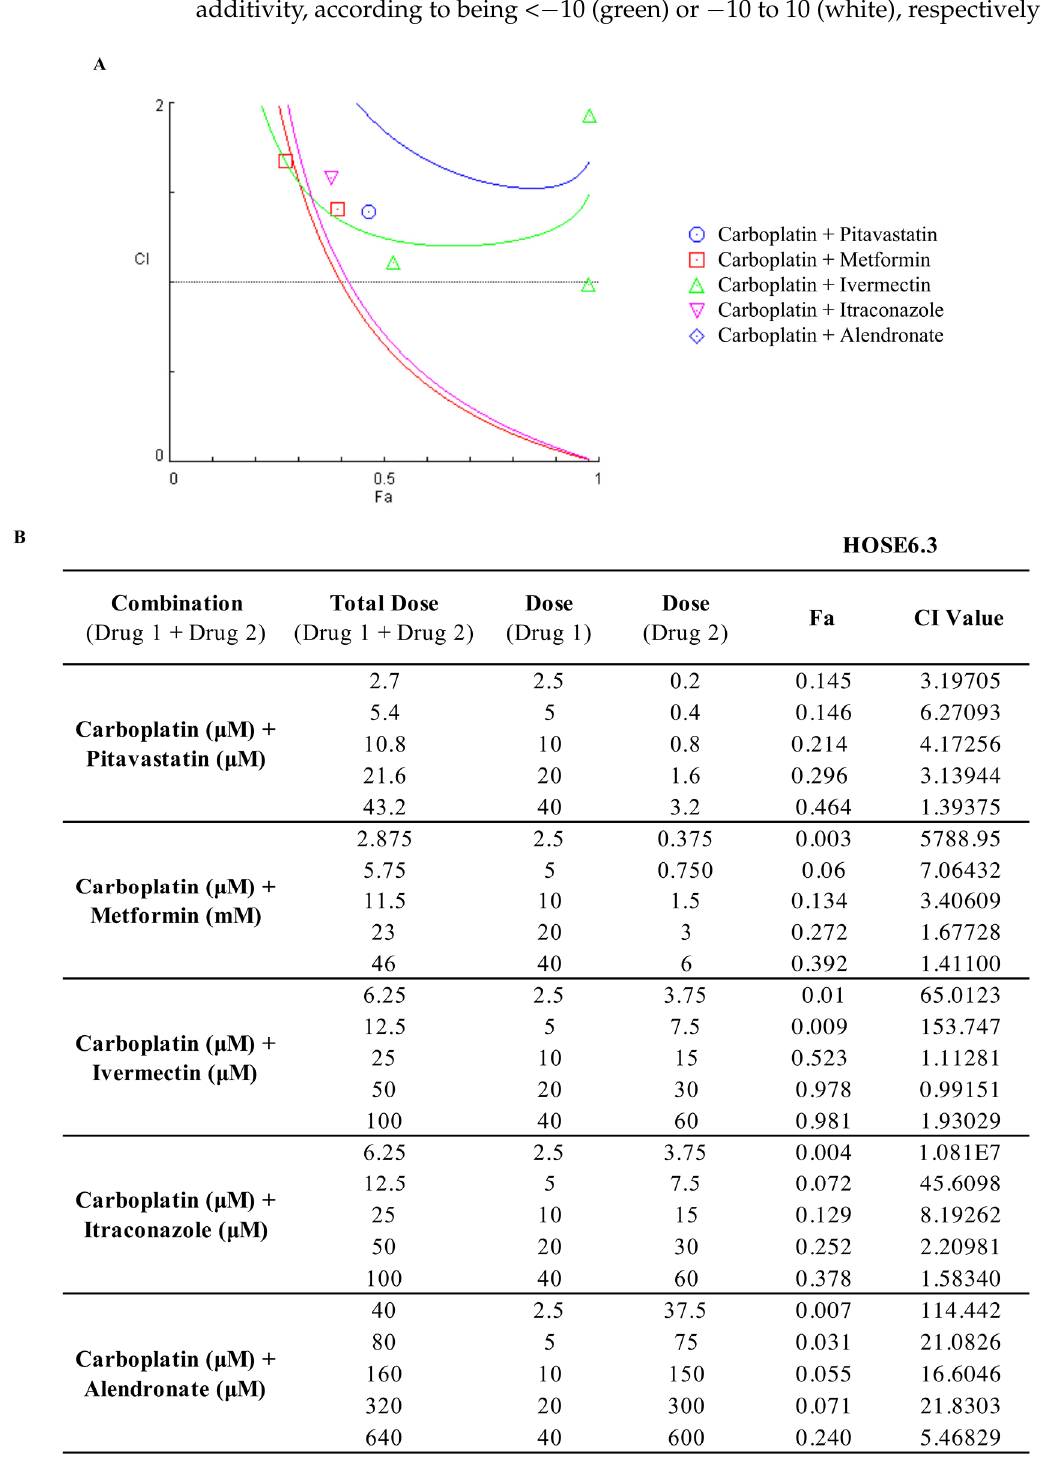
Figure 6. Combining Carboplatin with repurposed drugs has an antagonistic effect on HOSE6.3 cells. ( A ) Chou–Talalay method effect level (Fa)—Combinatory Index (CI) plot and ( B ) Fa values and re ‐ spective combinatory index (CI) values showing drug synergism of HOSE6.3 cells, after exposure to a fixed dose ratio that correspond to 0.25, 0.5, 1, 2 and 4 fold the individual IC 50 values each drug, e.g., Carboplatin combined with Pitavastatin, Metformin, Ivermectin, Itraconazole and Alendronate for 48 h. The combined treatment was co ‐ administered at the same time. All assays were performed in triplicate in at least three independent experiments. CI was plotted on the y ‐ axis as a function of Fa on the x ‐ axis to evaluate drug synergism. CI: <1 (synergism), =1 (additivity) and >1 (antagonism).